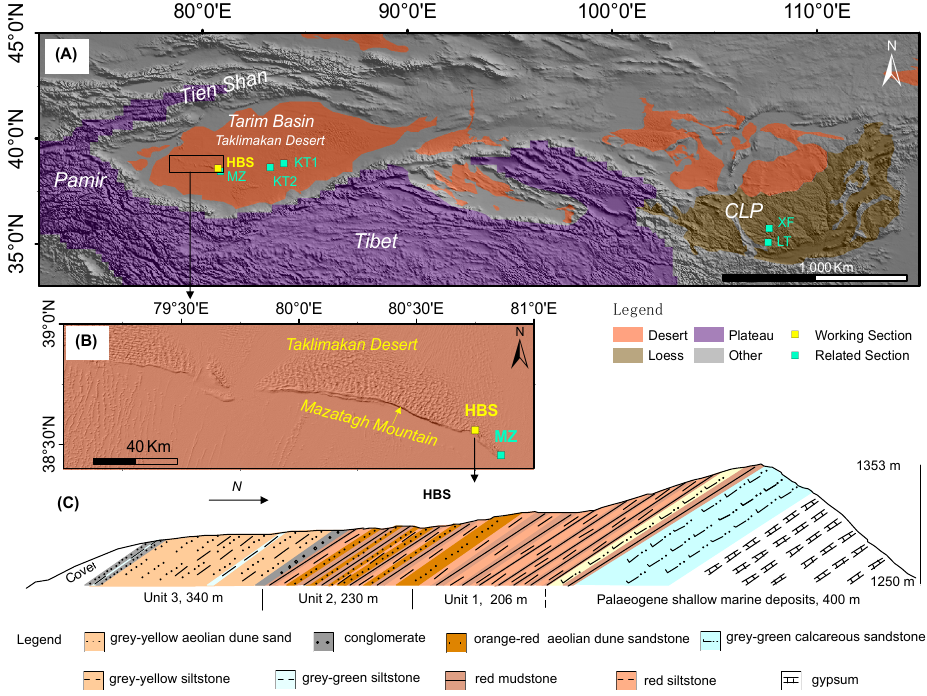
Fig. 1. Topography of northwestern China projected on digital elevation model (A) location of the Mazhatagh Mountain (B) , and schematic geological section of the HBS Section (C) .